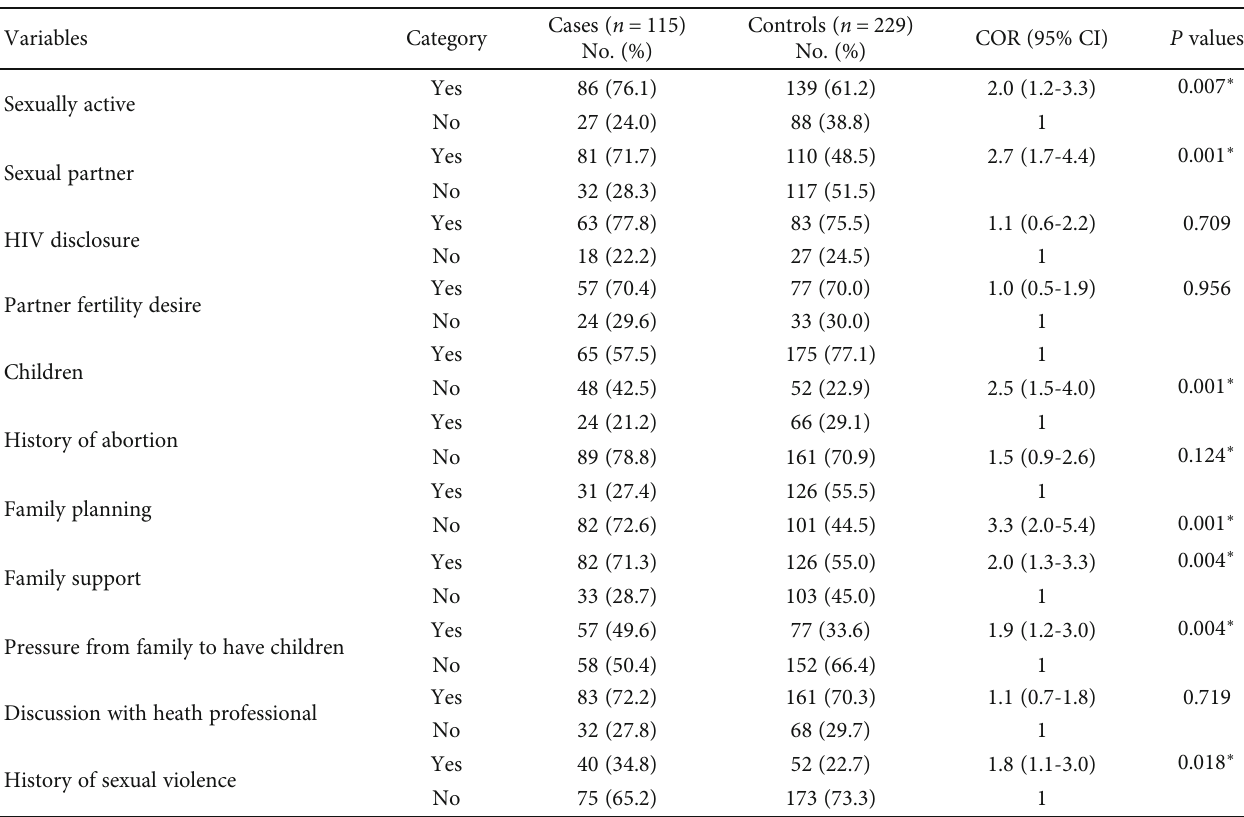
Figure 1: Fertility desire, number, and duration to have children among cases and reasons not to have children among controls of women living with HIV attending ART in Jimma University Medical Center, 2019 ( N = 344 ). Table 2: Bivariate analysis reproductive characteristics of women living with HIV attending ART in Jimma University Medical Center, 2019 ( N = 344